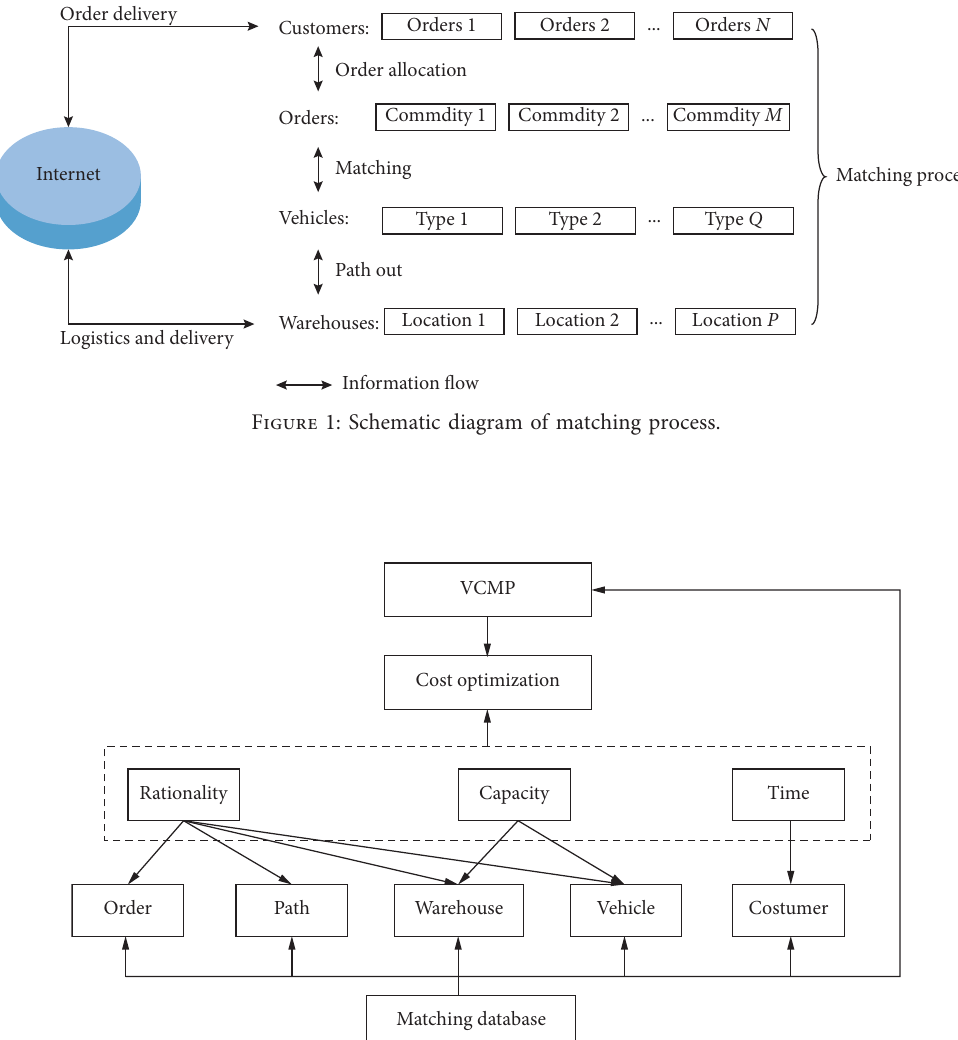
Figure 2: Logical block diagram of the